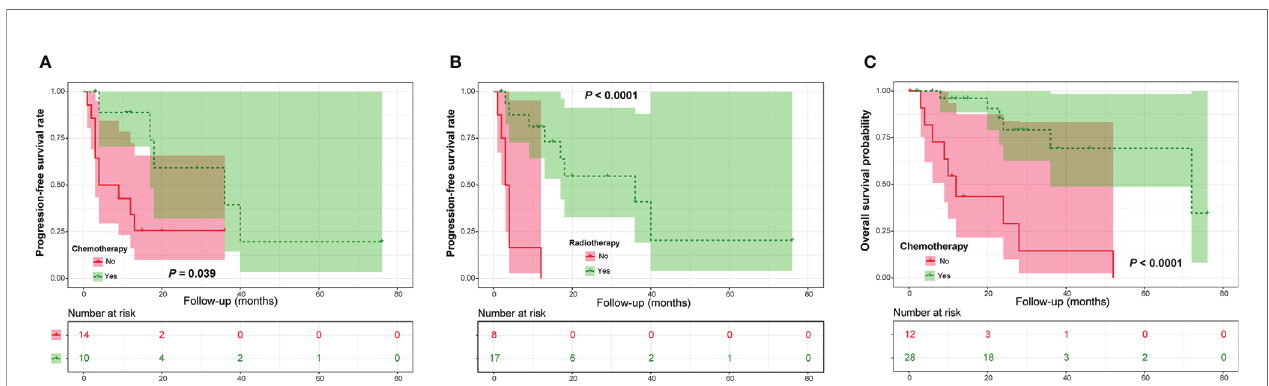
FIGURE 3 | Kaplan-Meier curves of progression-free survival of patients with poorly differentiated chordoma strati fi ed by adjuvant chemotherapy (A) and radiotherapy (B) , as well as overall survival of patients strati fi ed by adjuvant chemotherapy (C) .